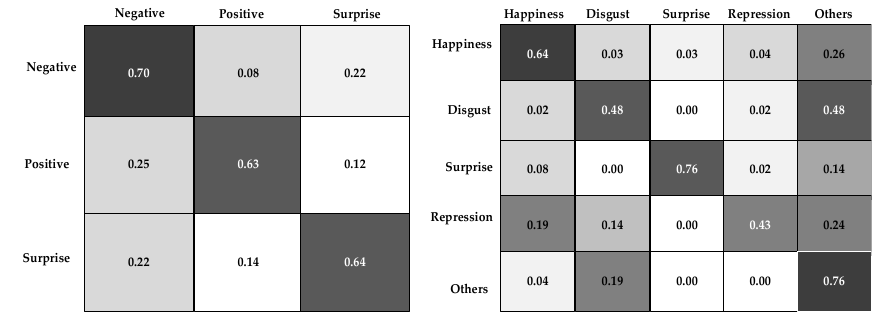
Figure 8. The confusion matrix of OFF3WD on SMIC and CASME II.